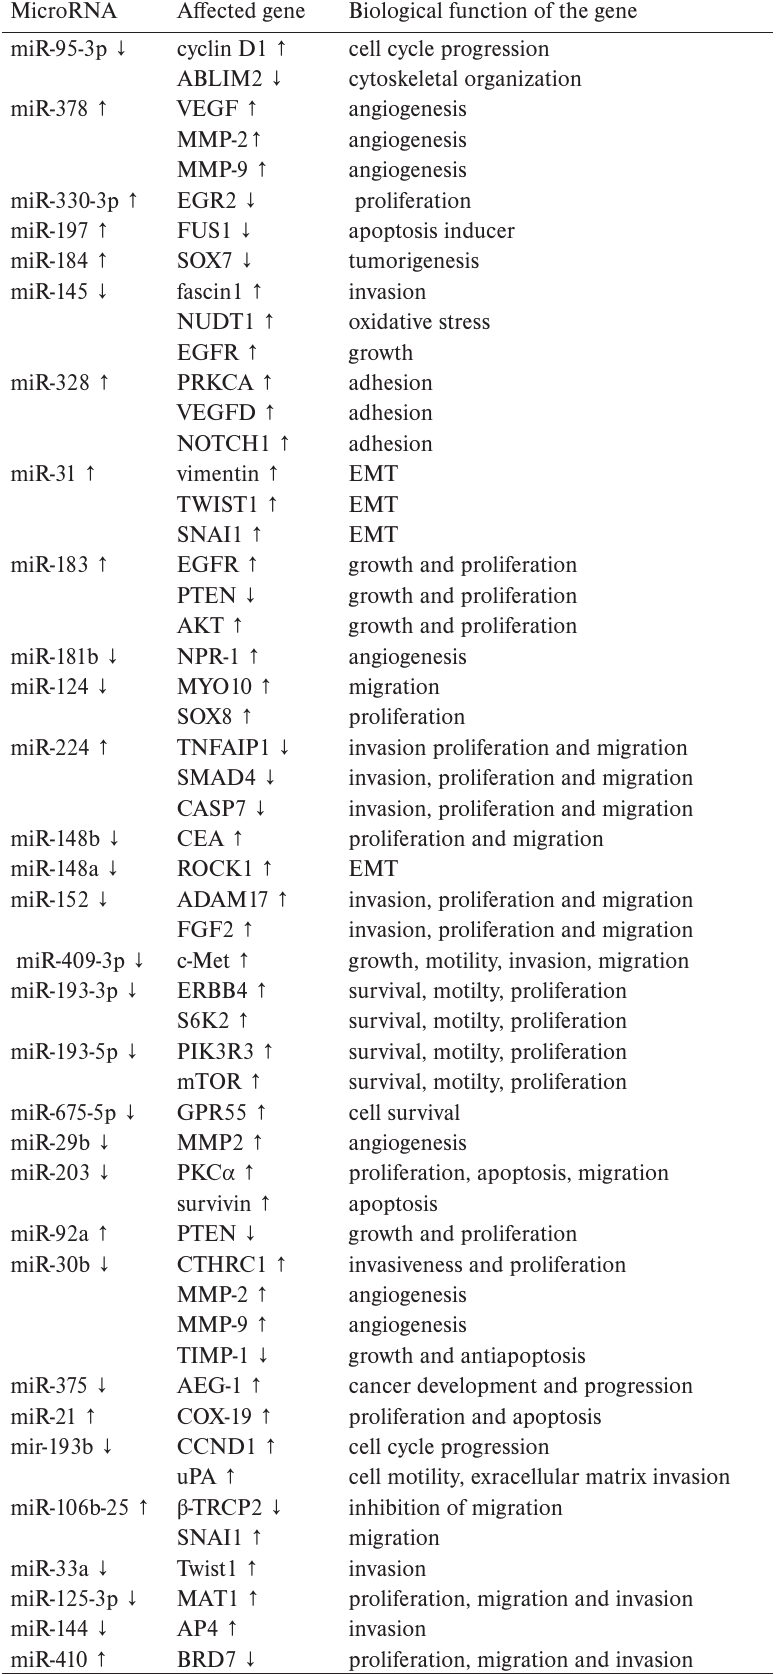
Table 1. contribution of dysregulated microrNas and their downstream target genes to metastatic processes of Nsclc tissues and cells.